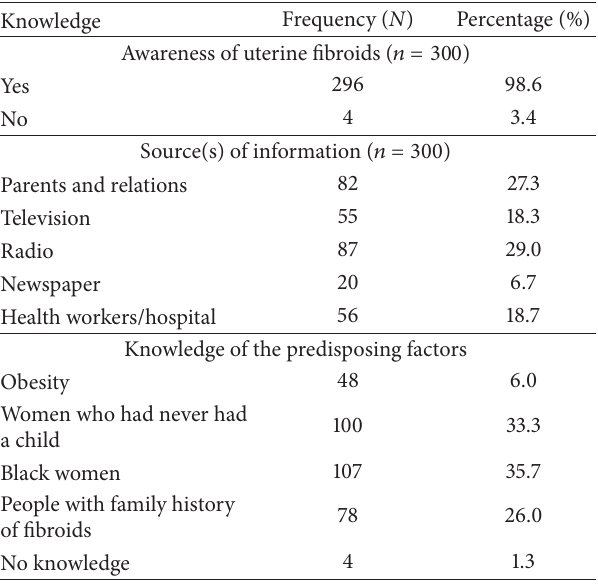
Table 5: Drugs used by respondents for treatment of